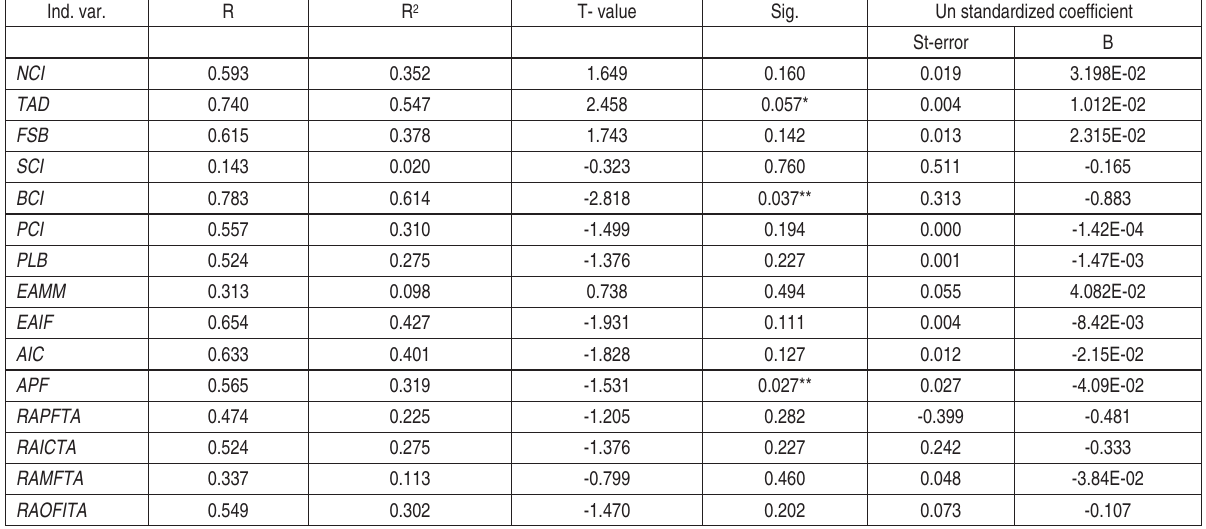
efficiency increase productivity and reduce costs, which affects positively and significantly on the bal- ance of prices and market demand. Table 5. Regression analysis of structural indicators for the European union banking system on HICP, an- nual average inflation rates Ind. var. R 2 T- value